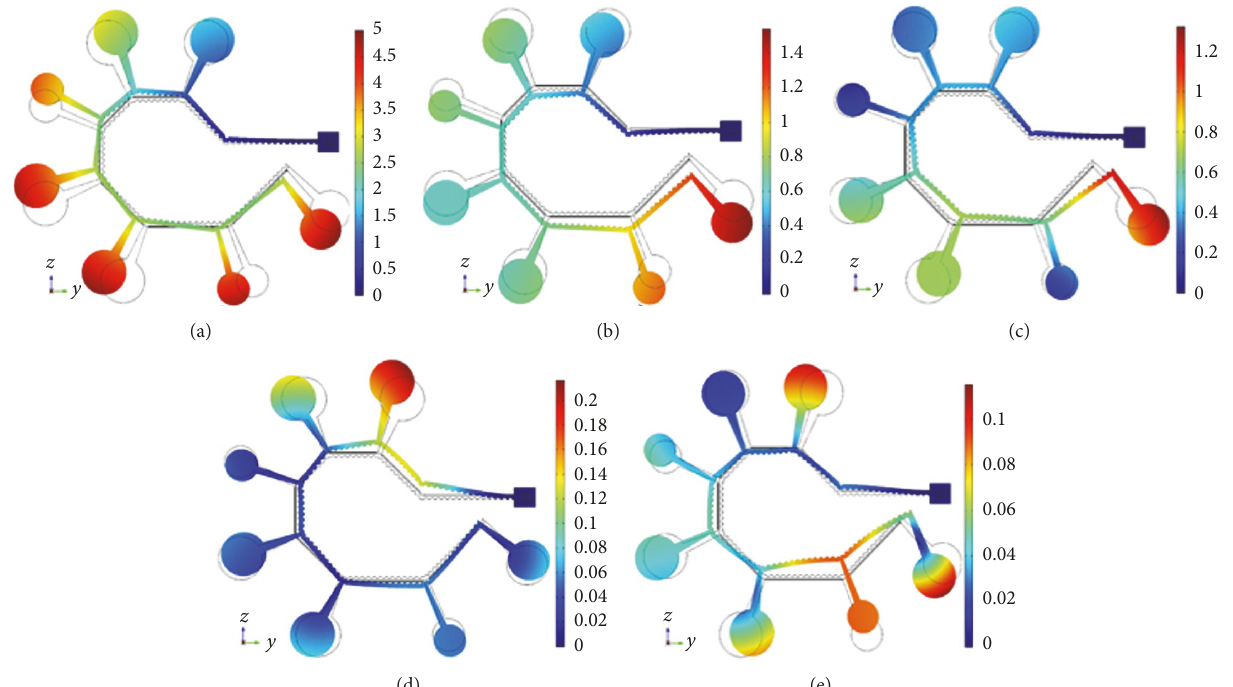
Figure 4: Modal shapes of the harvester: (a) 14.41Hz; (b) 25.926 Hz; (c) 73.981 Hz; (d) 199.53 Hz; (e) 214.56 Hz.